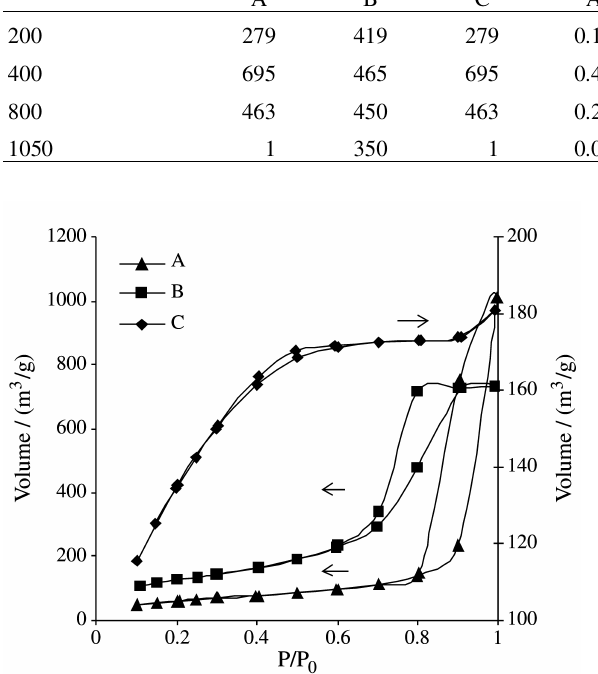
Figure 6. Nitrogen adsorption-desorption for degassed silica gels.